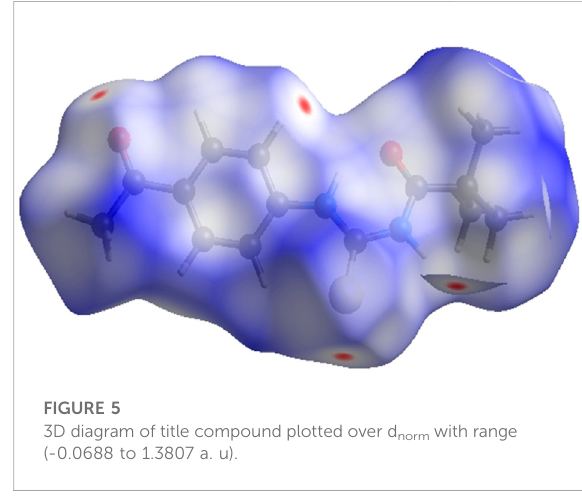
FIGURE 3 Interaction of ligand (3) (A) a -amylase (B) Urease (C) Acetylcholinesterase and (D) Butyrylcholinesterase.